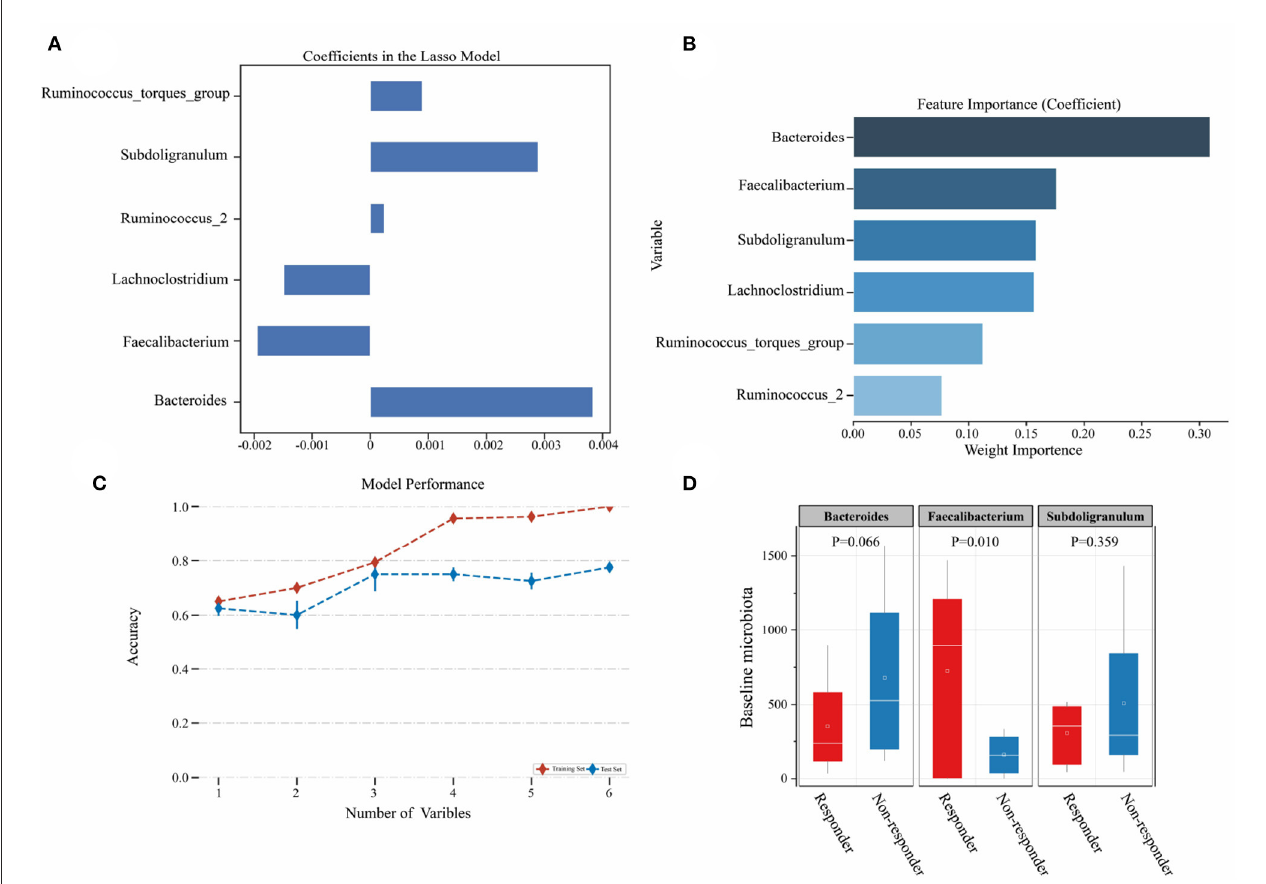
FIGURE8 Screening of baseline characteristics of the gut microbiota in BP responders. (A) Screening of characteristic microbiota of BP responders at baseline; (B) Ranking of feature importance; (C) Model evaluation; (D) Baseline characteristic flora abundance; Whiskers are drawn to a minimum and maximum values, but not further than 1.5 ×